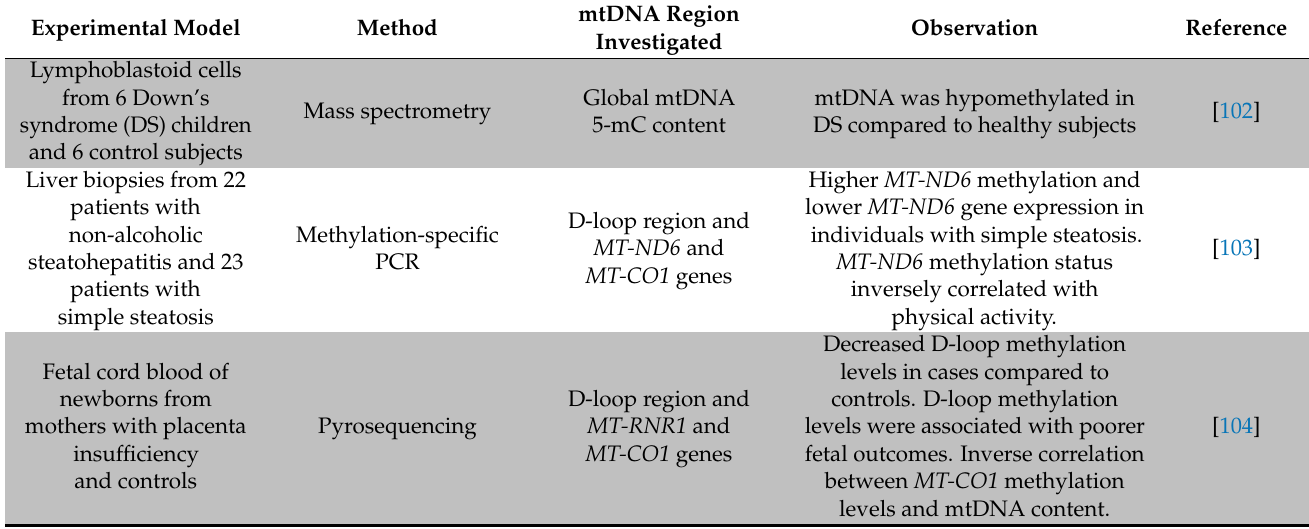
Table 5. mtDNA methylation studies in other